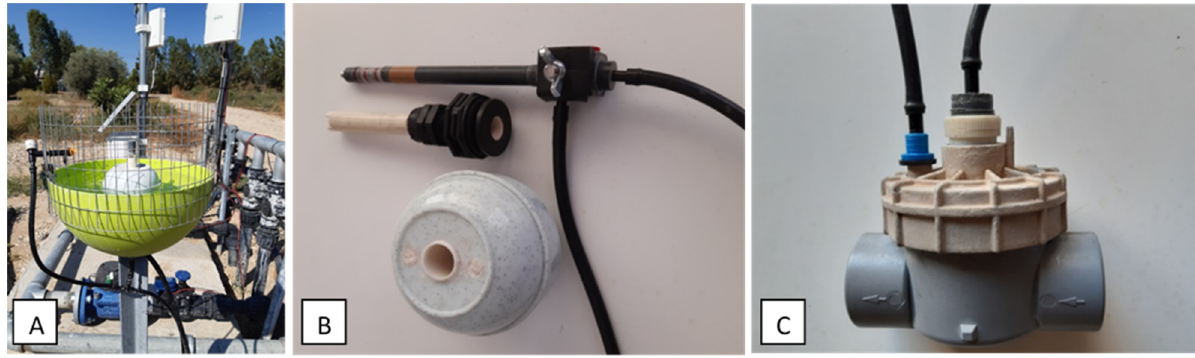
Figure 2. A Hydraulic Evapotranspiration Multisensor ( A ) and different components ( B , C ).